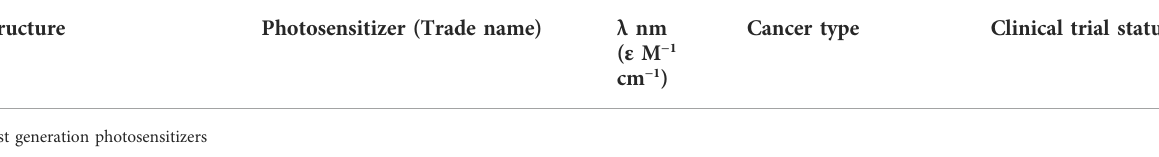
TABLE 1 List of few photosensitizers in clinical